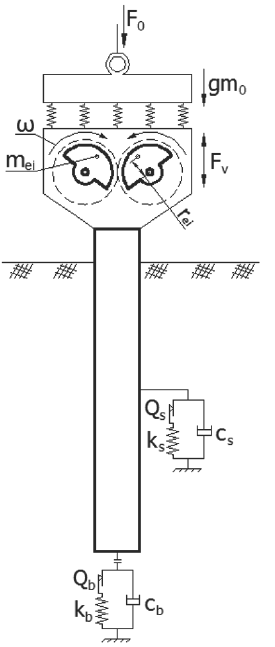
pile bottom. The reduction of shaft from 15 kN·s/m to 0.1 kN·s/m at the depth of (bottom pile at 1.4 m)